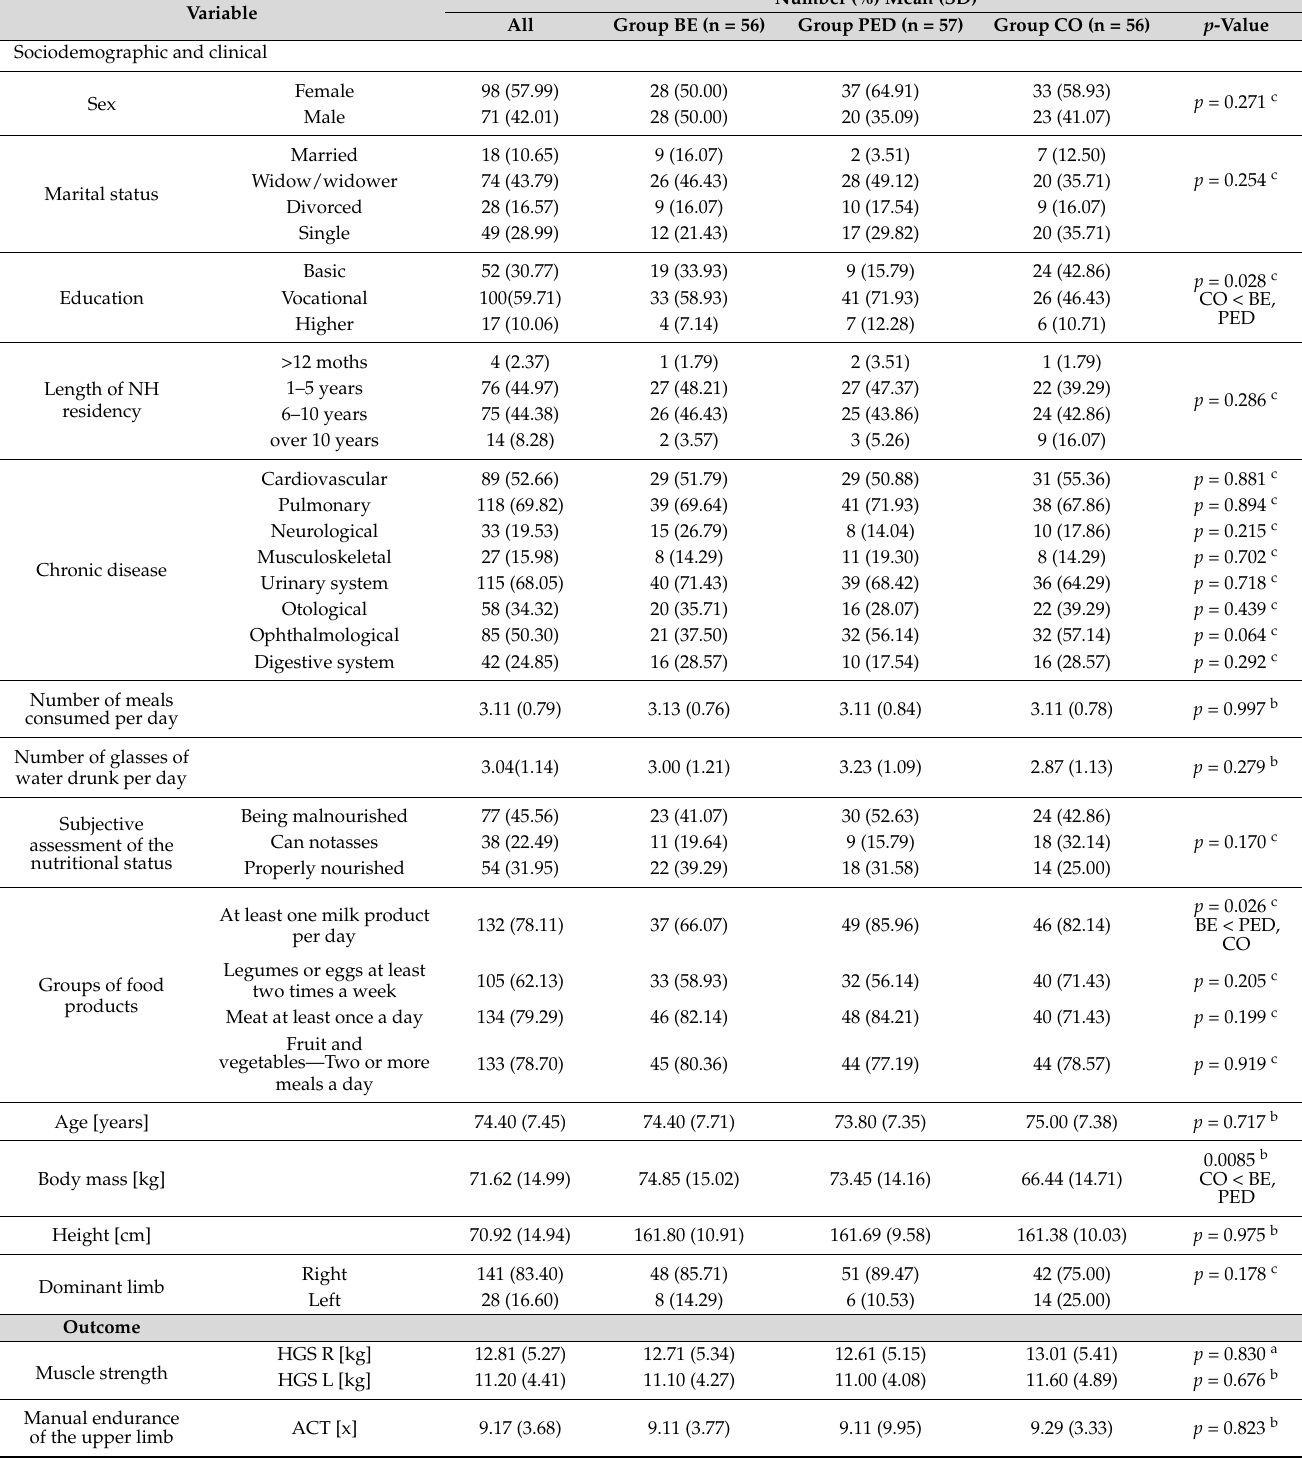
Table 1. Sociodemographic and clinical characteristics of the